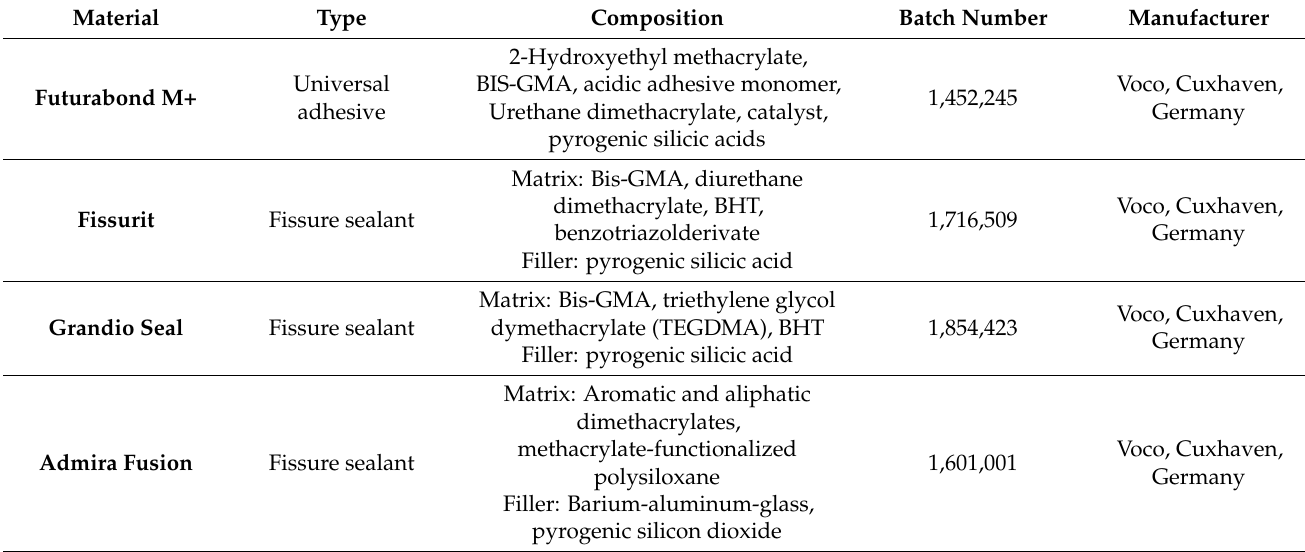
Table 1. Adhesive system used for Groups 2–4 and fissure sealants